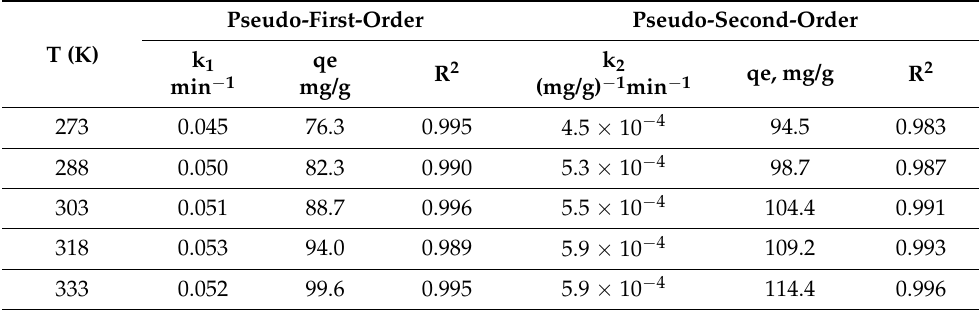
Table 4. Analysis of the kinetics of the adsorption of AZM on AFAC using different kinetic models.